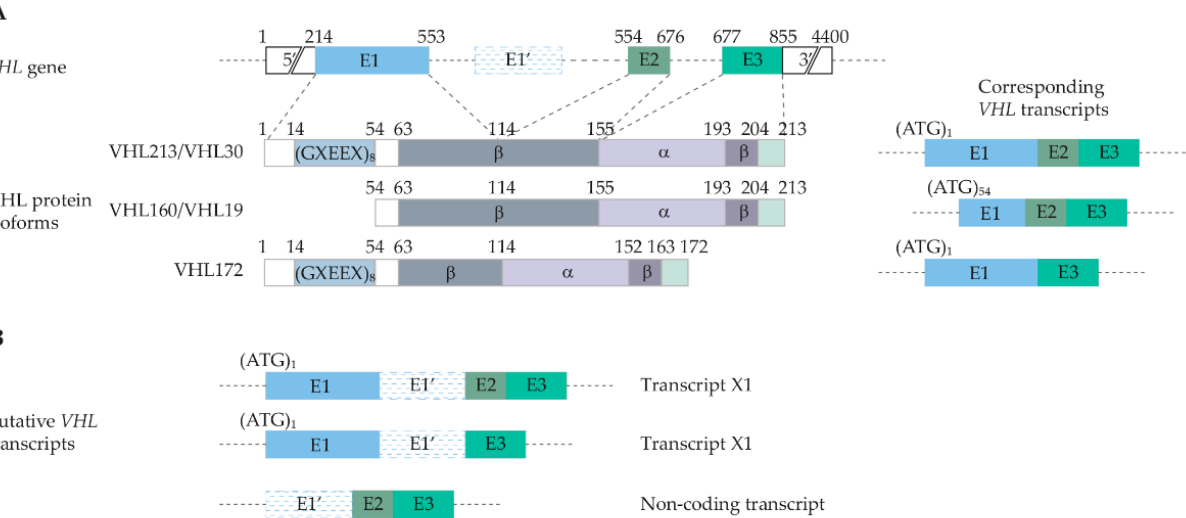
Figure 1. Schematic representation of VHL gene structure. ( A ). VHL gene structure and protein isoforms with corresponding VHL transcripts. ( B ). Putative VHL transcripts, containing exon E’, identified by cloning and sequencing [15].